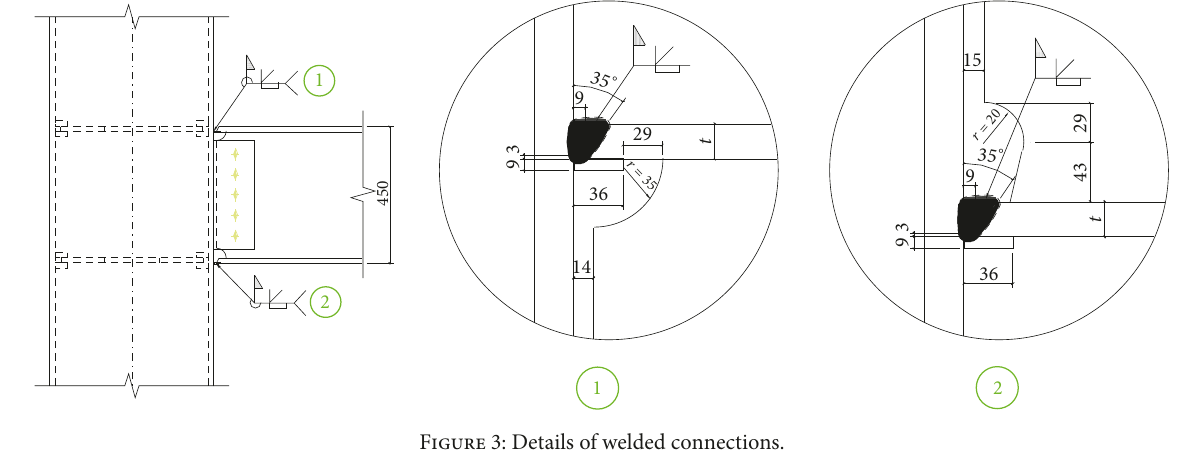
Figure 3: Details of welded connections.